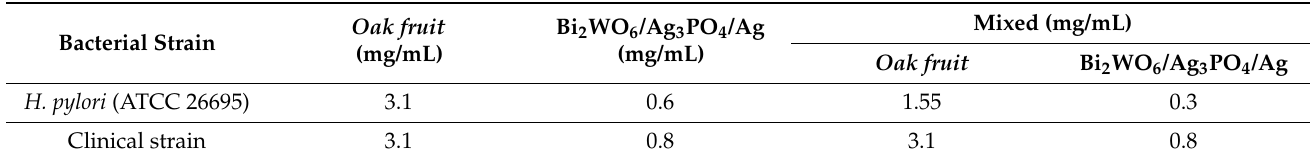
Figure 2. MIC and MBC for H. pylori (ATCC 26695), (red stars = calculated MIC for photocatalyst and phytobiotic.). Table 1. The MIC of extracted Oak fruit , Bi 2 WO 6 /Ag 3 PO 4 /Ag and mixed them against the H. pylori (ATCC 26695) and H. pylori clinical strain.